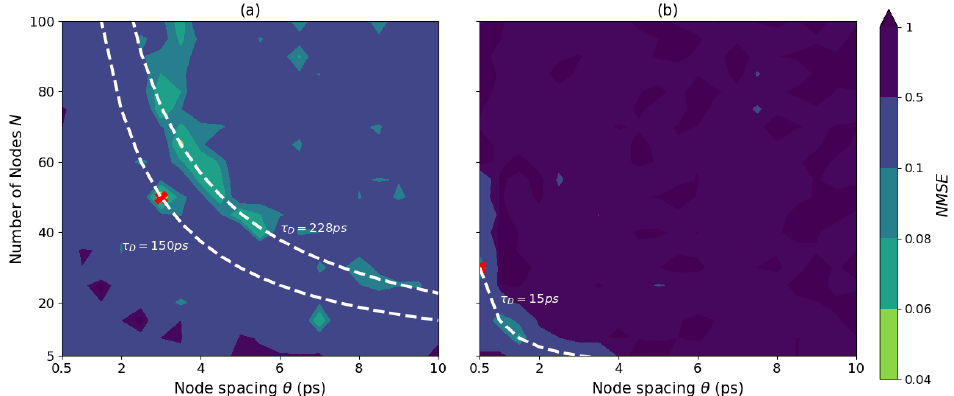
Figure 2. Santa Fe timeseries prediction performance, indicated by the NMSE , color-coded unto the parameter space spanned by N and θ for ( a ) η = 1 ns − 1 and ( b ) η = 100 ns − 1 . The delay time was fixed to match the mask length, τ D = τ M . The red crosses denote the minimum NMSE achieved over the scanned space and the white dashed lines are a guide to the eye, denoting a constant delay time τ D and hence constant mask length τ M